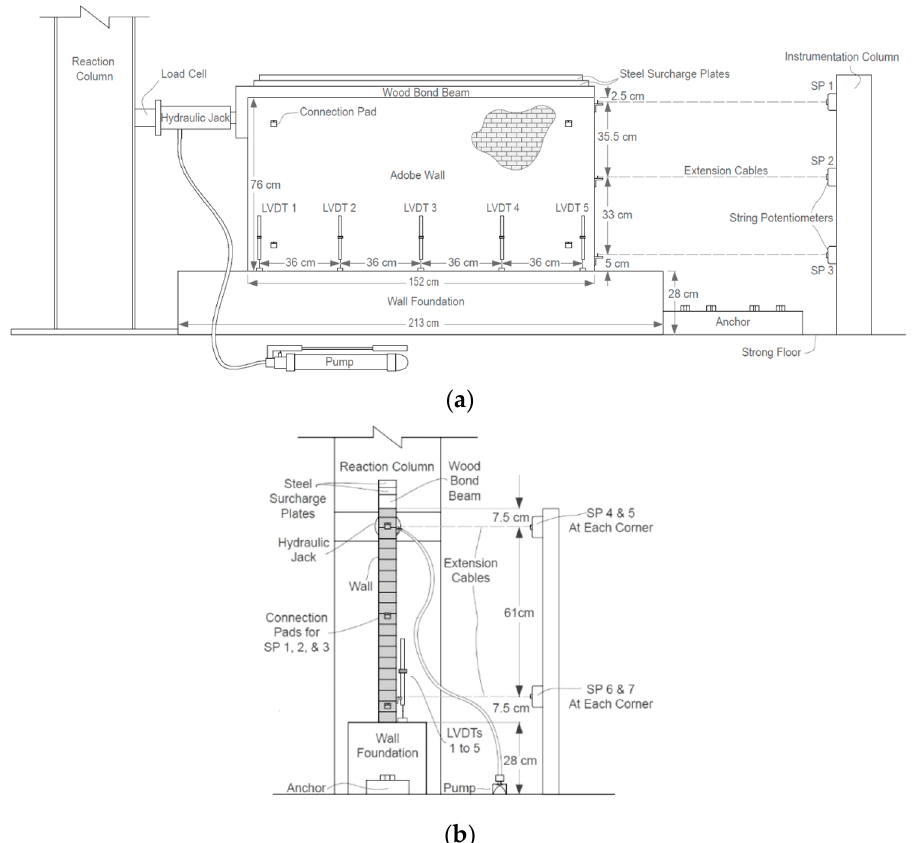
Figure 2. Wall test setup and instrumentation: ( a ) front view, ( b ) side view.